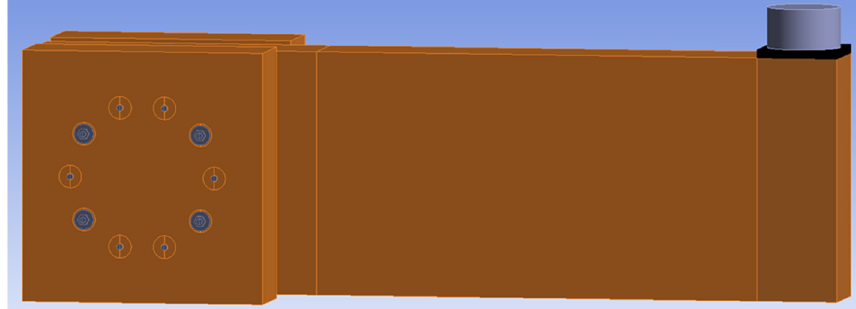
Figure 10. Numerical model for Experiment A, bolts and dowels.